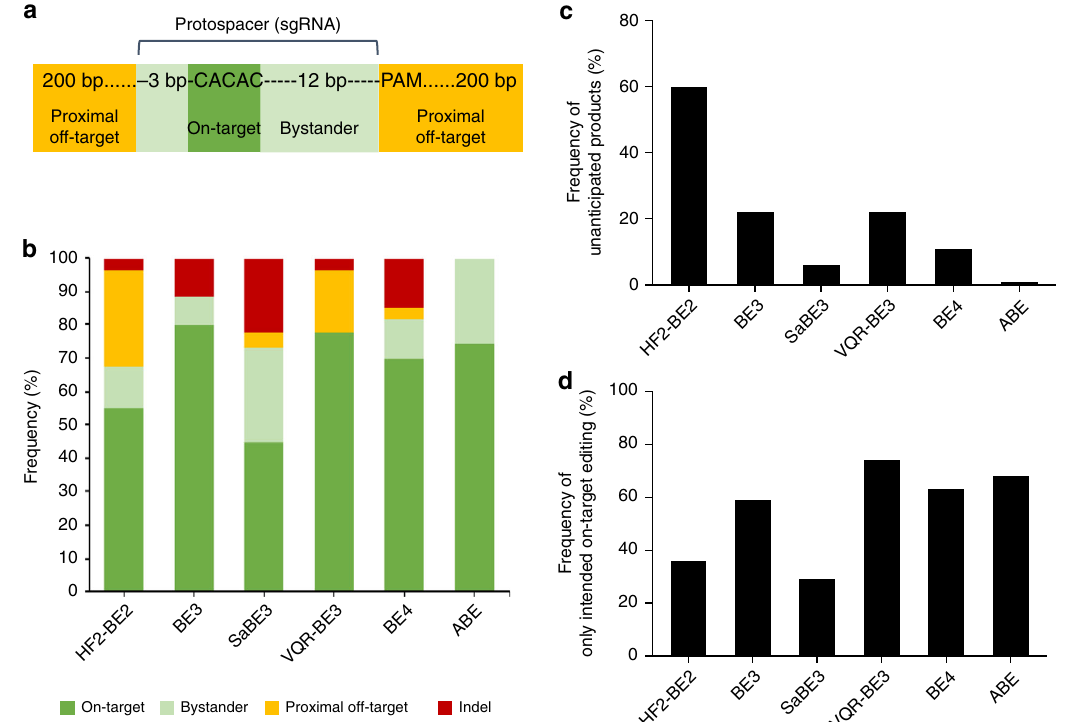
Fig. 1 Base editing frequency and accuracy. a Diagram of a generic target locus with different categories of editing outcomes. On-target (dark green): the target nucleotide within the 5-bp editing window; bystander (light green): a non-target nucleotide within the protospacer; proximal off-target (yellow): outside the protospacer but within 200 bp of the target site. b Frequency of alleles carrying on-target mutation, bystander mutation, proximal off-target mutation, and indels. Note that a single allele can carry more than one mutation. The total number of mutant alleles obtained with each base editor was set as 100% (HF2-BE2, 58; BE3, 96; SaBE3, 45; VQR-BE3, 27; BE4, 33; and ABE, 263). The frequency of each category is shown and number of edited alleles for each group and each base editor are shown in Table 1. c Frequency of alleles carrying unanticipated products (any mutation different from